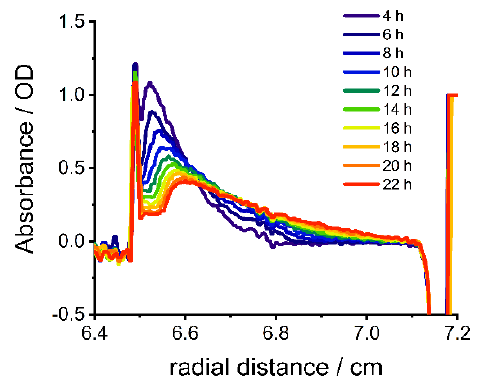
Figure 8. Absorbance profile of gelatin with superparamagnetic iron oxide nanoparticles (SPIONs) against radial distance from axis of rotation at different times after overlaying at λ = 450 nm at 40 °C.